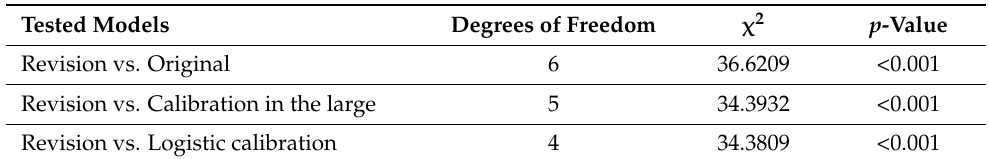
Table 3. Performance metrics of the developed models.